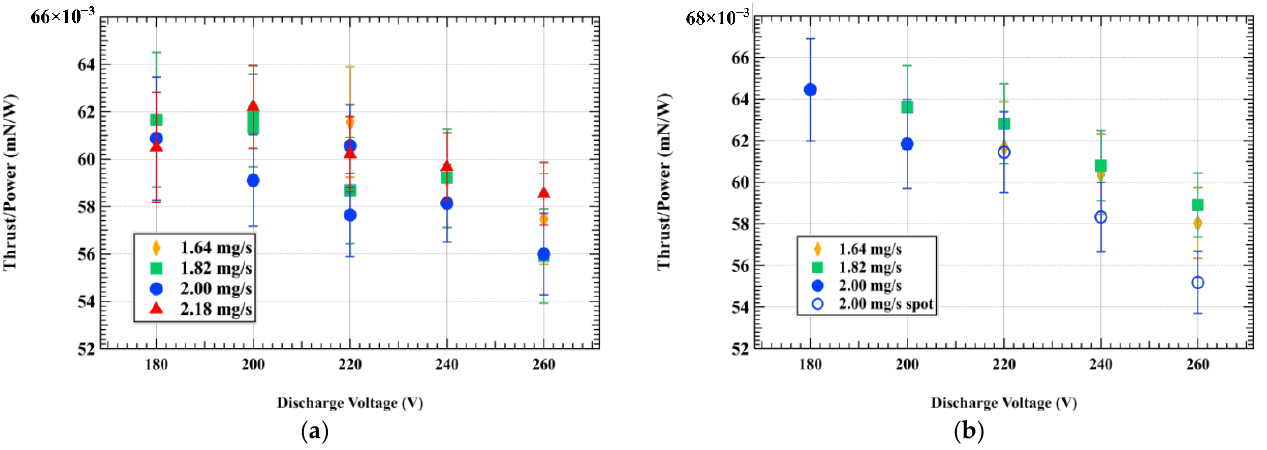
Figure 9. ( a ) Thrust-to-power ratio as a function of discharge voltage and anode mass flow rate for 5-s tests; ( b ) thrust-to- power ratio for the 15-s test.